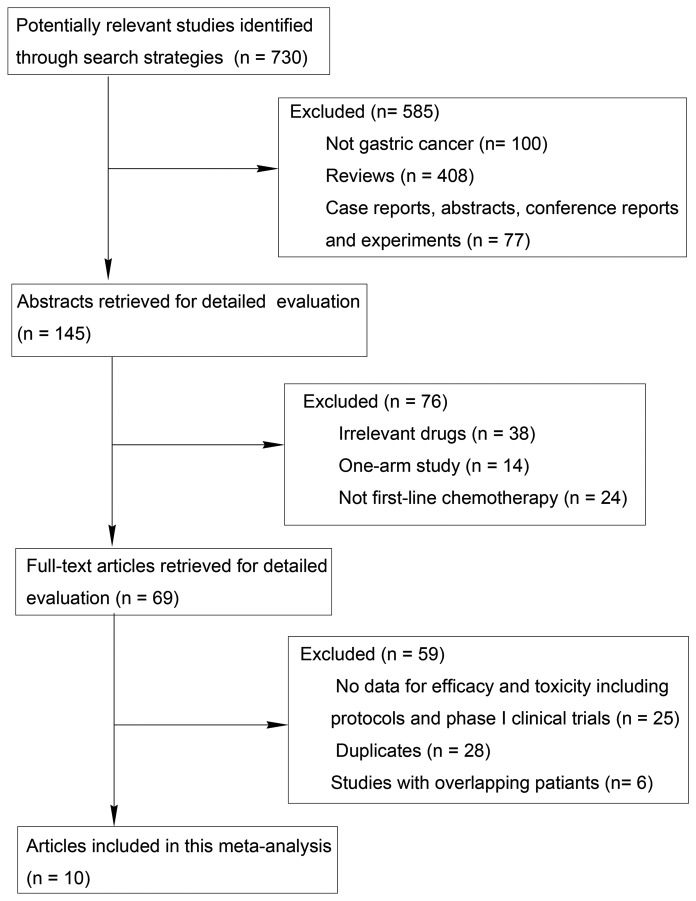
Meta-analysis profile summarizing trial flow.